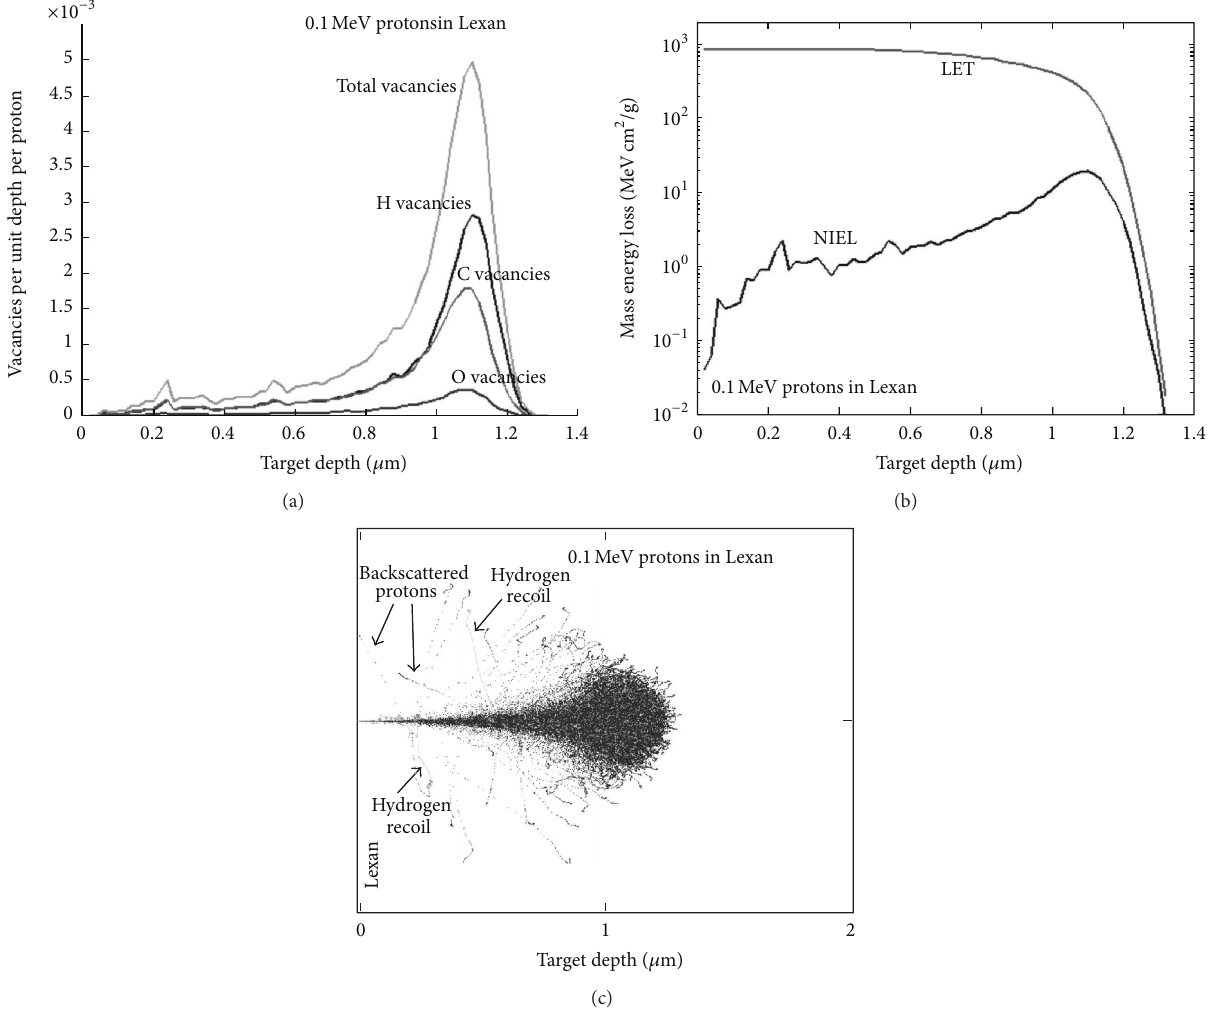
Figure 5: Plots of (a) vacancy concentrations and (b) mass energy losses (LET and NIEL divided by material density) along the depth of a 0.2 𝜇 m thick lexan (polycarbonate) film. (c) Tracks of protons and recoiling atoms. Results were obtained from simulations of 10 4 proton histories, for a 0.1MeV incident proton